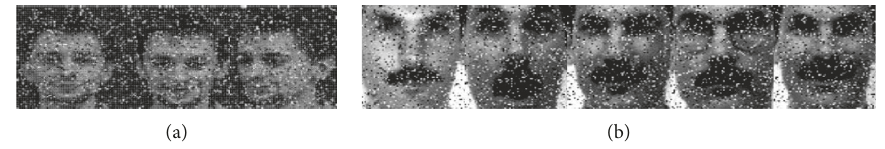
Figure 5: The testing images with the random pixel corruptions from one class. (a) IMM. (b) Yale.